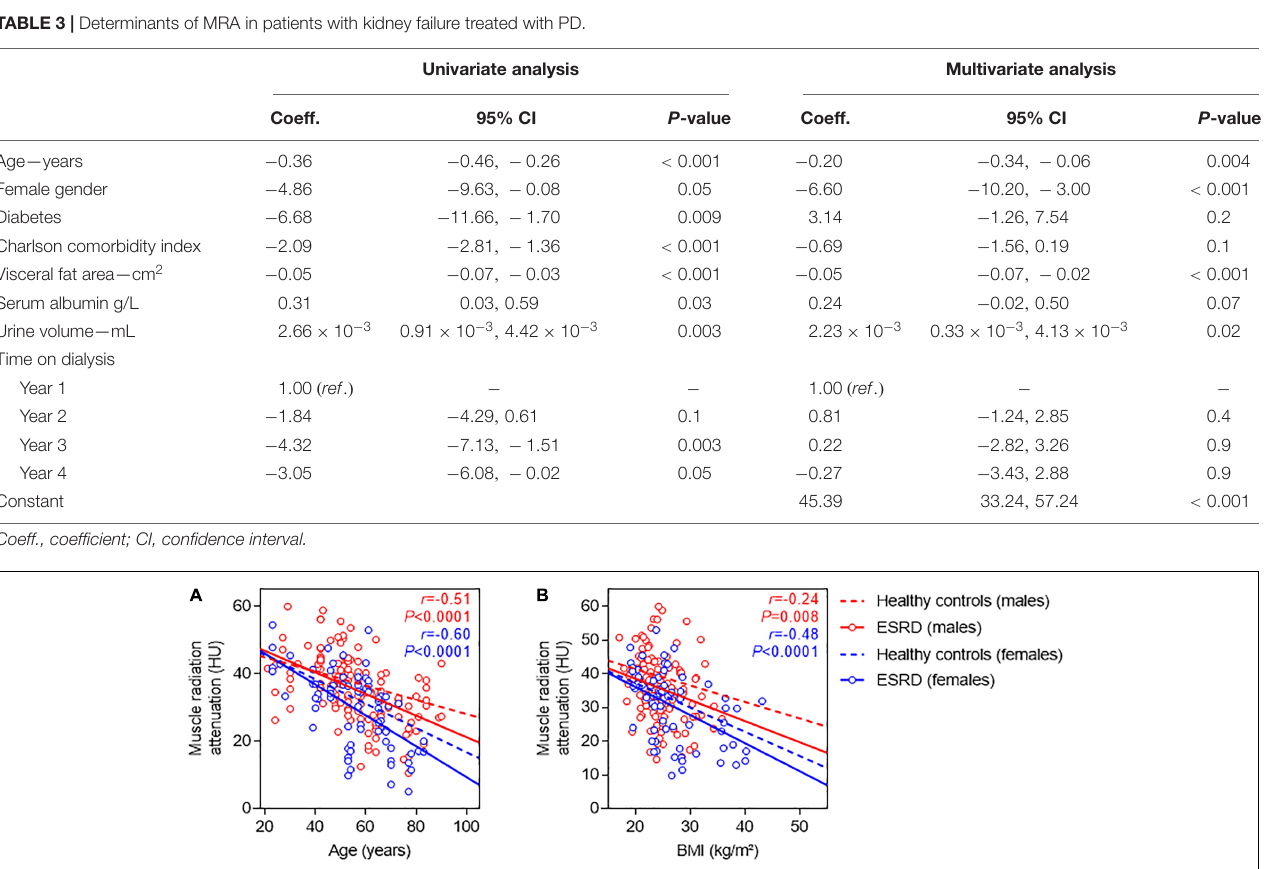
FIGURE 3 | Relationship between muscle radiation attenuation, gender, age, and body-mass index in patients with kidney failure, and comparison with patients with normal kidney function. Relationship between MRA and age (A) , and MRA and body-mass index (BMI) (B) , among male (red) and female (blue) patients with ESKD. Regression lines between MRA and age, and MRA and BMI in patients with ESKD (continuous lines) are compared with those from reference values obtained in patients with normal kidney function (dotted lines) (van der Werf et al., 2018).